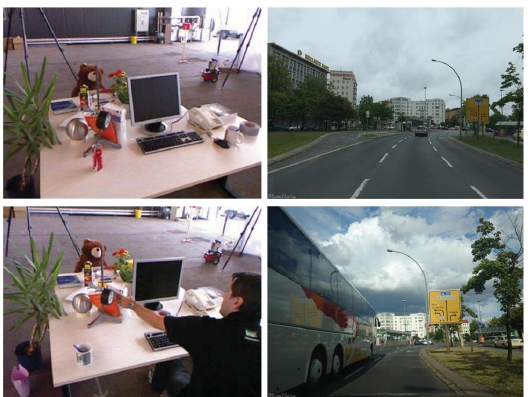
Figure 3. Occlusion in features of same place due to moving objects such as person [128] and vehicles [126].